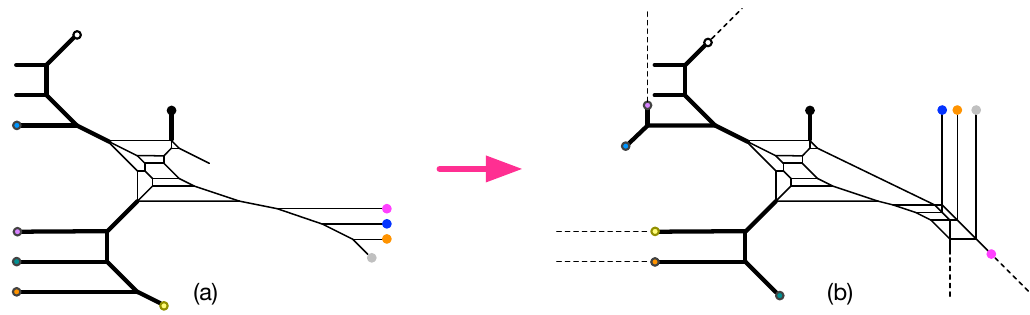
TAS + 1 AS + 9 F theory. (b) Its Tao 2